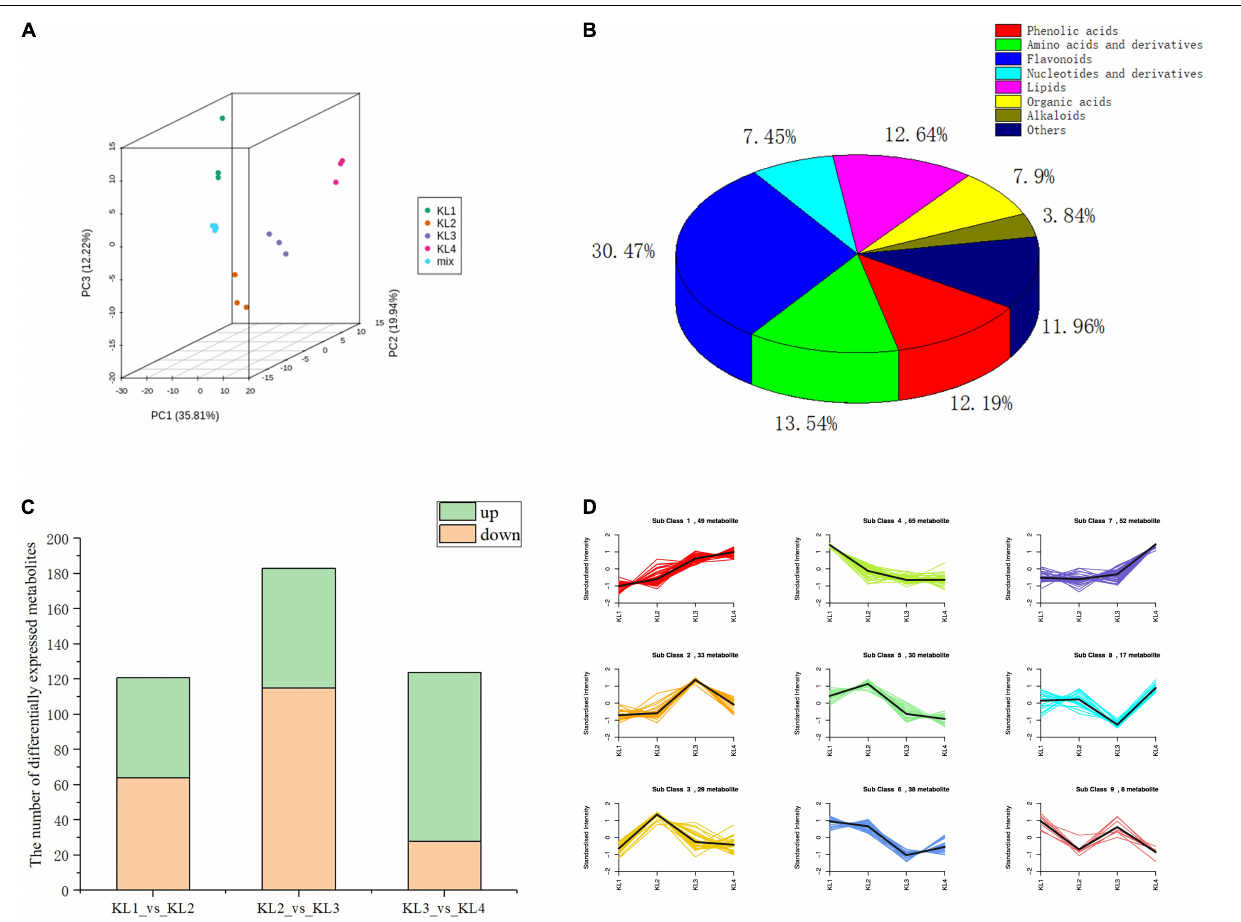
FIGURE 2 | The analysis results of the metabolic profiles obtained by LC–MS during the development of watermelon fruit. (A) Principal component analysis (PCA) score plot of all metabolites in 12 samples. KL1, KL2, KL3, and KL4 represent the samples at 10, 18, 26, and 34 days after pollination, respectively (DAP). The samples with the same color represent three biological replications of the same period. (B) Pie chart of the classification of 443 metabolites. (C) The number of differentially accumulation metabolites (DAMs) by comparing KL1 vs. KL2, KL2 vs. KL3, and KL3 vs. KL4. Green represents the number of up-regulated metabolites, On the contrary, orange stands for down-regulation. (D) Dynamics of Metabolite during four development stages. The bold black line represents the average pattern of all candidate metabolites in each class; the different colored lines represent different classes, and each line represents the average relative value of the metabolite over three biological